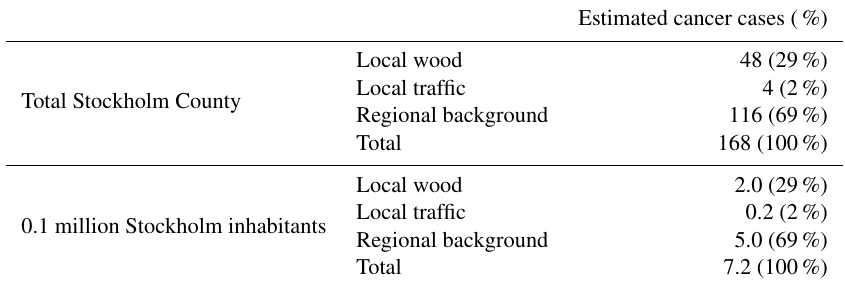
Figure 10. Scatterplot and Spearman correlation coefficient ( r S ) of measured meteorological and air quality parameters against levoglucosan level at the urban background (TK). ∗ Statistically significant with p< 0 . 05, ∗∗ Statistically significant with p< 0 . 01, ∗∗∗ Statistically significant with p< 0 . 001. Table 4. Estimated lung-related cancer cases in Stockholm